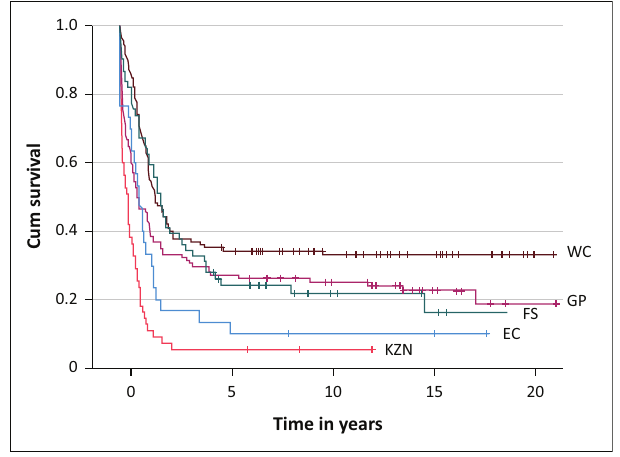
FIGURE 2: Kaplan Meier curves overall survival outcomes for patients diagnosed with neuroblastoma between 2000 and 2014 in each province ( p <